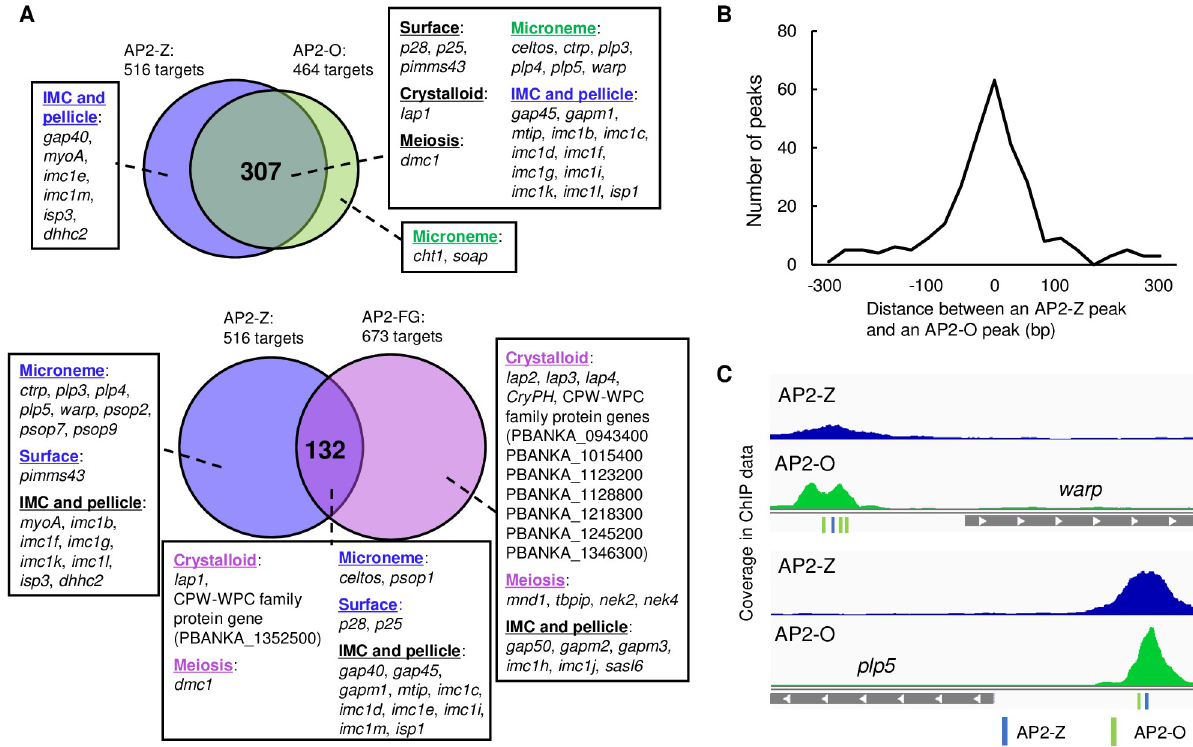
Fig 8. Comparison of the target genes between AP2-Z, AP2-O, and AP2-FG. (A) Venn diagrams showing the overlap between the target genes of AP2-Z and AP2-O (top) and AP2-Z and AP2-FG (bottom). Genes were assigned according to previous literature [24,36–44,50–75]. (B) Distance between ChIP peaks of AP2-Z and AP2-O in the upstream region of their common targets. (C) Representative peak images of the common target genes of AP2-Z and AP2-O. Positions of AP2-Z and AP2-O binding motifs are indicated in blue and green, respectively.